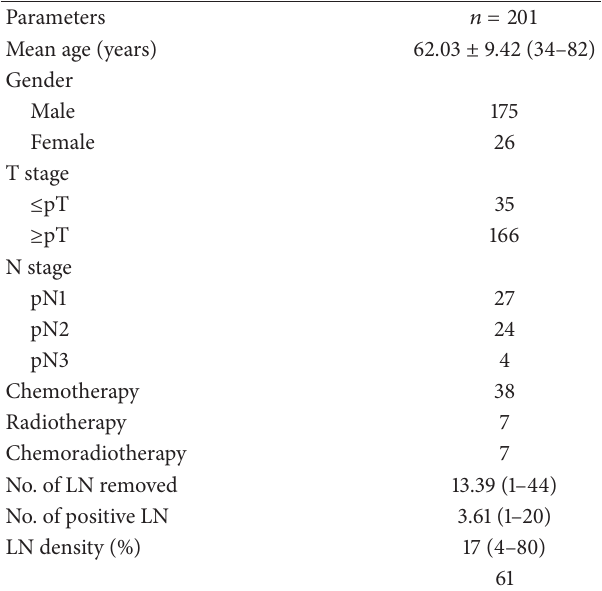
Table 1: Characteristic features of